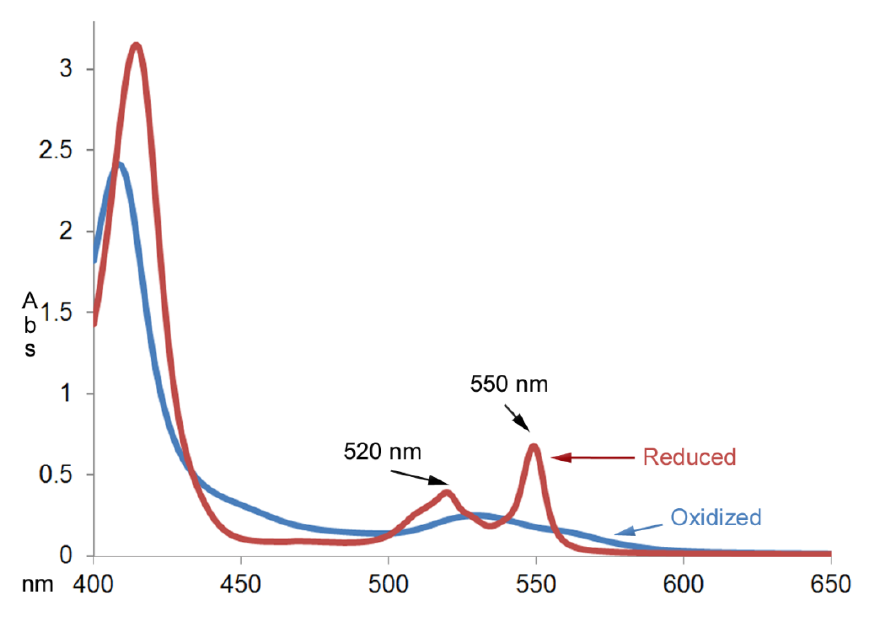
Figure 2. UV-Vis absorption spectra of cytochrome c (0.025 mm) before and after reacting with excess amount of EGCG (1.00 mm) for an hour at room